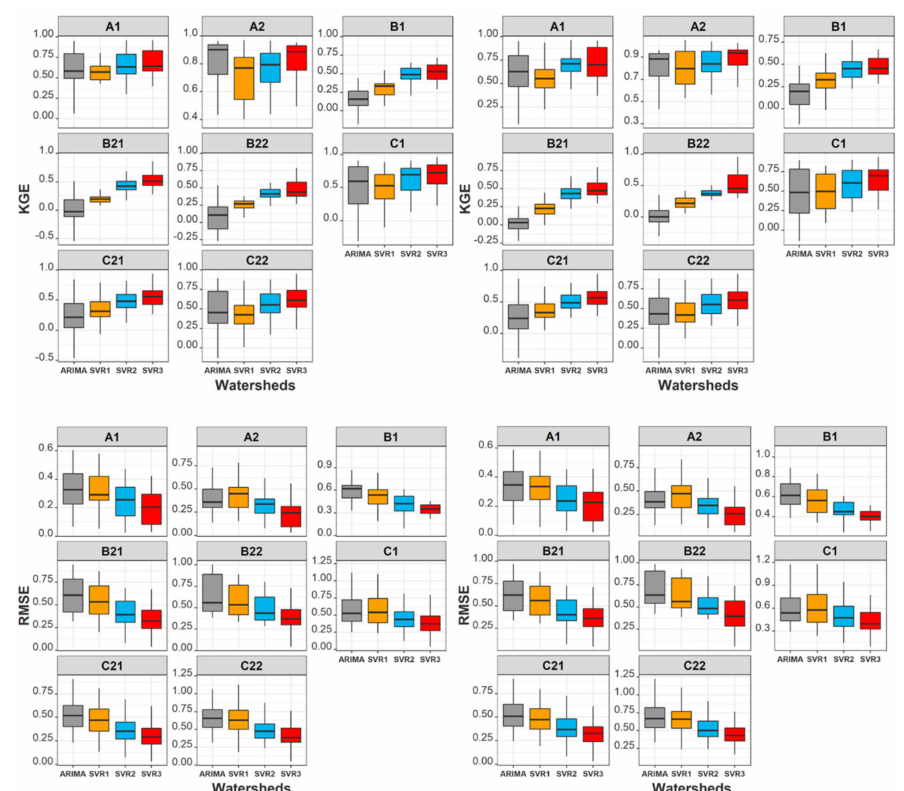
Figure 10. Kling-Gupta e ffi ciency (KGE) ( top ) and root mean square error (RMSE) ( bottom ) boxplots of the Q arima, Q svr1, Q svr2 and Q svr3 models during calibration ( left ) and validation ( right ) period for the eight watershed